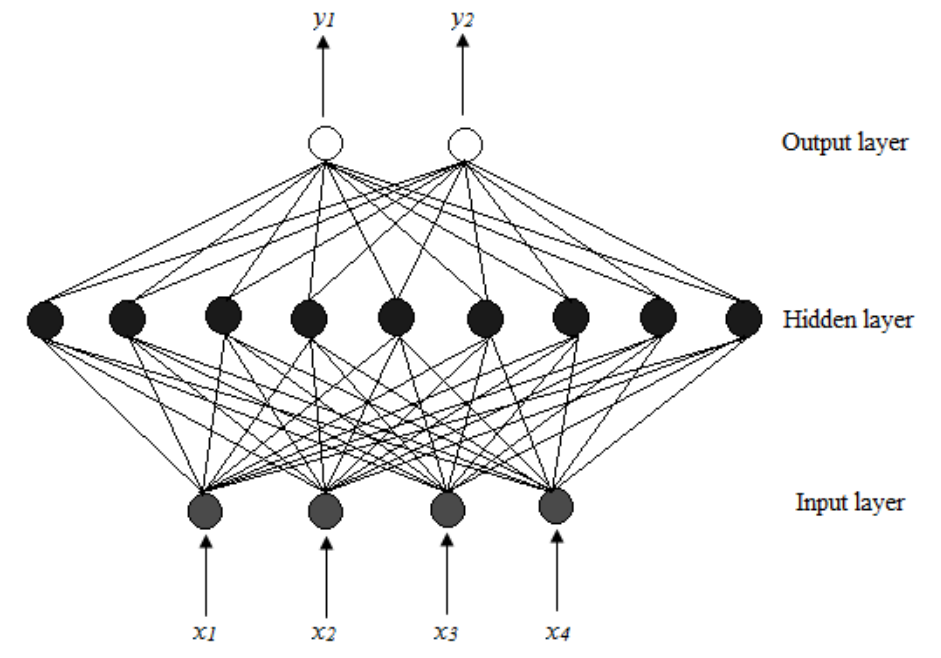
Figure 1. MLP architecture for a feed forward back propagation ANN where x and y represent response factors inputs and y 1 2